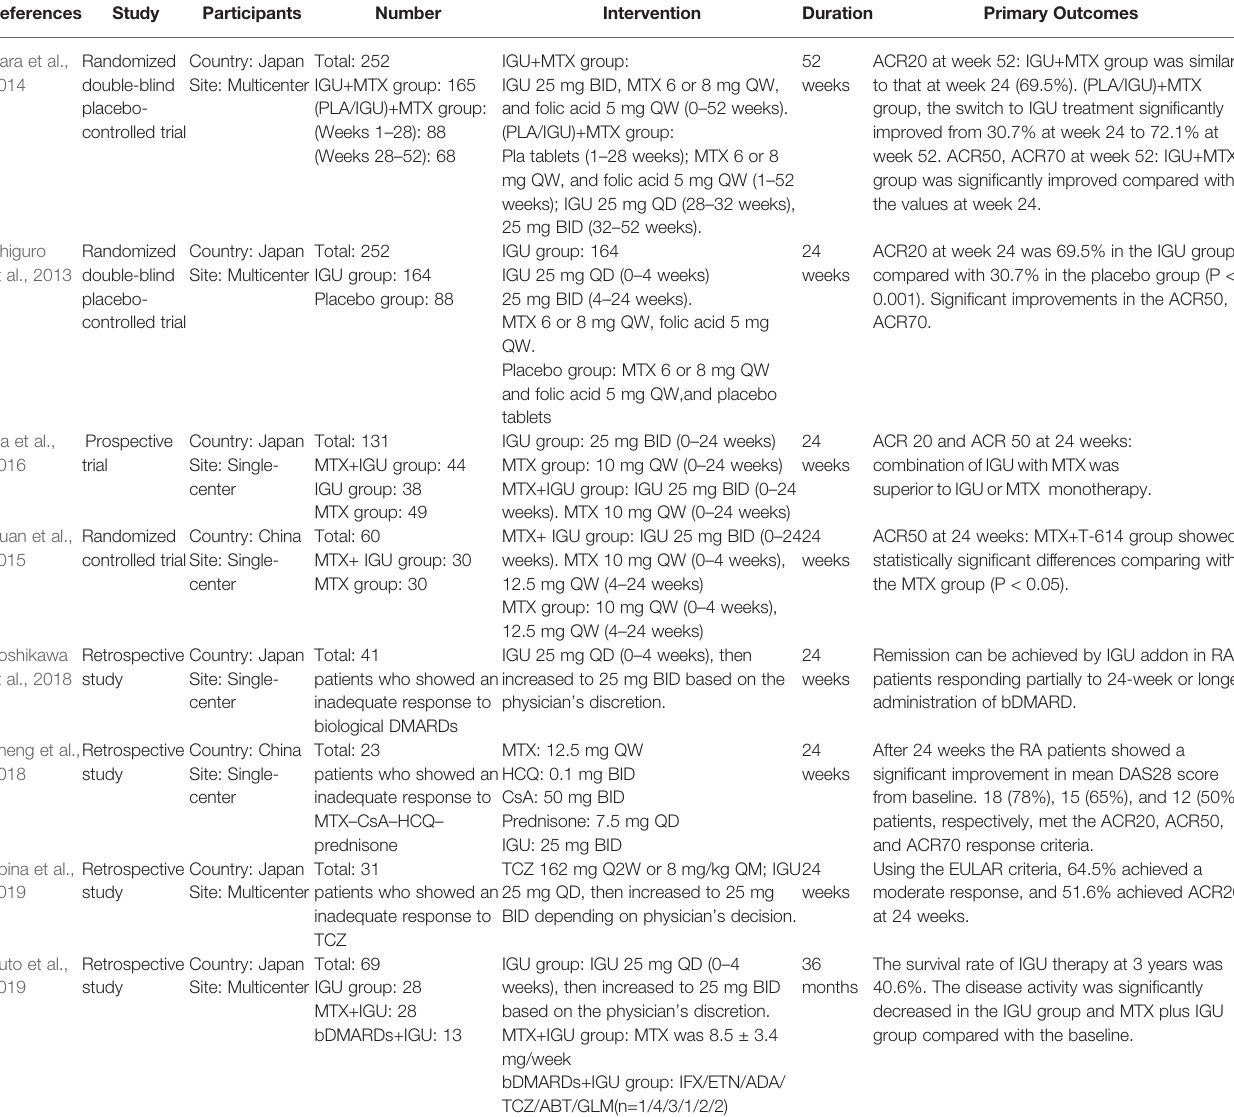
TABLE 2 | Characteristics of the clinical trials of iguratimod in combination for